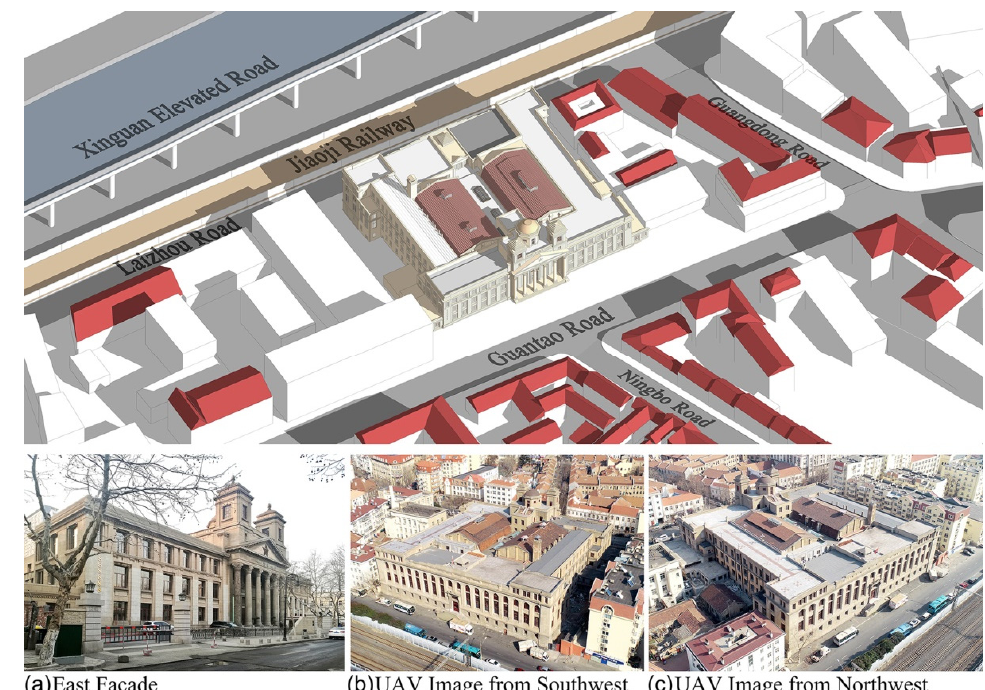
Figure 3. Qingdao Exchange Building.